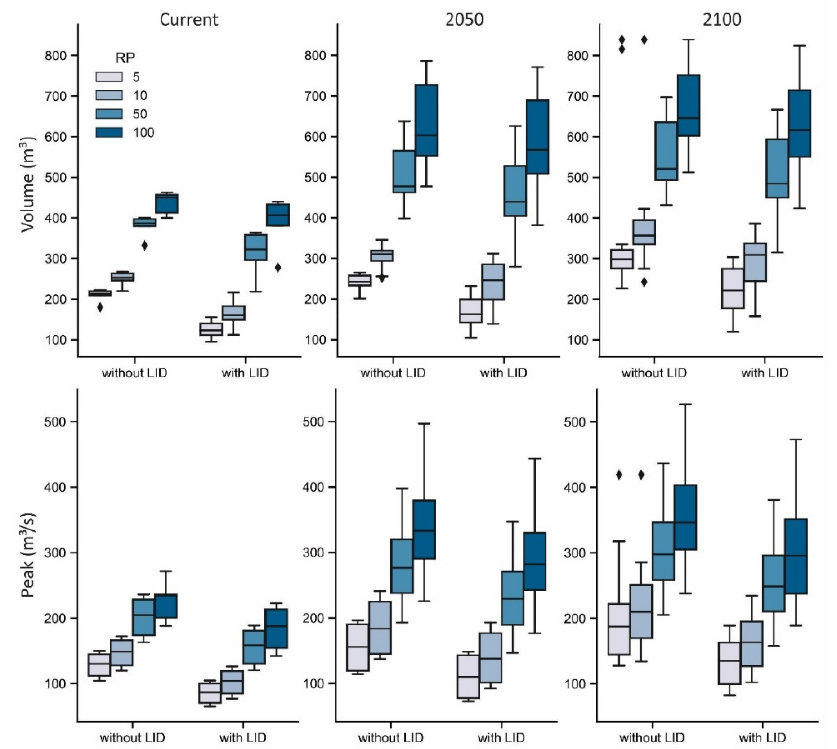
Figure 5. Comparison of hydrological variables for current and future scenarios with and without applying LID practices. The black rhombuses are the data outliers.